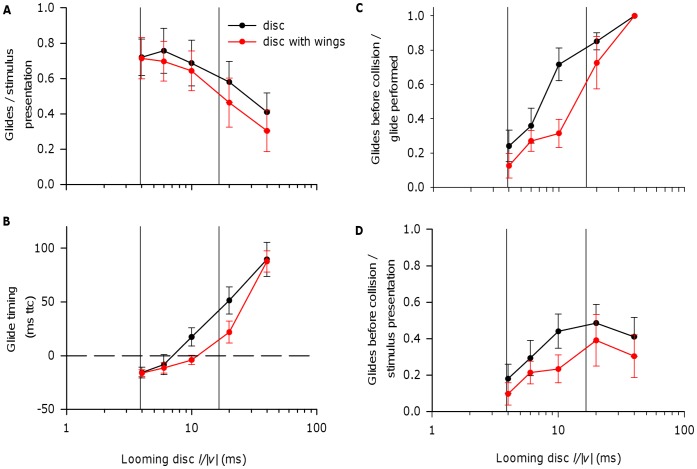
The effect on gliding responses of adding wings to looming discs with varying l/|v|.A, Adding wings to looming discs caused a small, non-significant decrease in the relative frequency of glide occurrence across l/|v| values (see text). In this and following panels, vertical lines indicate the estimated range of kite-like l/|v| values as in Fig. 2. B, The addition of wings to a looming disc appeared to delay the timing of glide initiation at l/|v| 10.0 and 20.0 ms (but not at 4.0 and 6.0 ms). Overall, addition of wings to a looming disc had a significant effect on glide timing. However, a significant difference (p<0.05) in glide timings between the winged and unwinged discs at a given l/|v| value was only found at l/|v| 10.0 ms (see text). Dashed line is the calculated time of collision. C, D, The addition of wings to a looming disc caused a small reduction in the proportion of glides that were successfully initiated before collision (C), and in the number of glides initiated before collision as a proportion of stimulus presentations (D). See text for statistical tests. Panel A, D: N = 10 locusts (value for each individual calculated from 5–6 presentations of each stimulus). Panels B, C: Varying numbers of individuals make up the data points at each l/|v| since locusts that did not glide could not be included. N at l/|v| 40.0 ms no wing = 7; wing = 5; l/|v| 20.0 ms no wing = 9; wing = 7; remaining l/|v|s with and without wings = 9. In all panels, means plotted ± SEM.